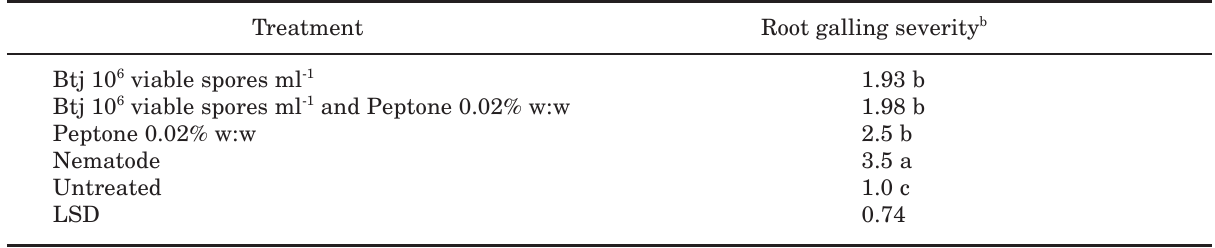
Table 3. Effect of Bacillus thuringiensis jordanica (H71) (Btj) on Meloidogyne javanica and its damage to tomato in a field experiment